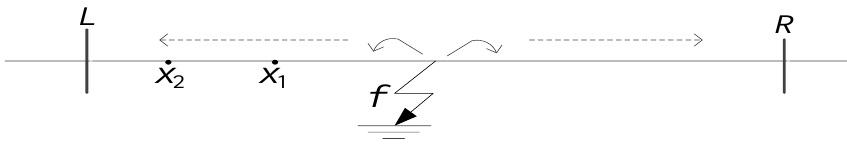
Figure 1. The propagation of a traveling wave.